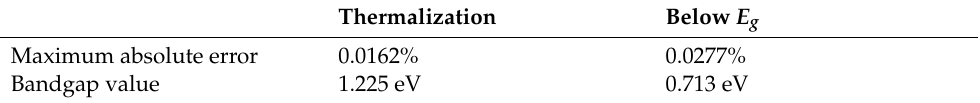
Table 2. Material and layer properties used in the simulation.